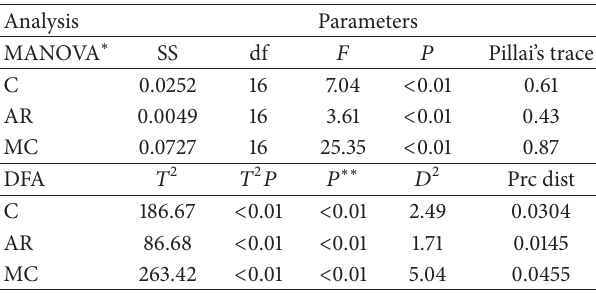
Table 2: Ucides cordatus (Linaeus, 1763): statistical results for comparison of shape variation between males and